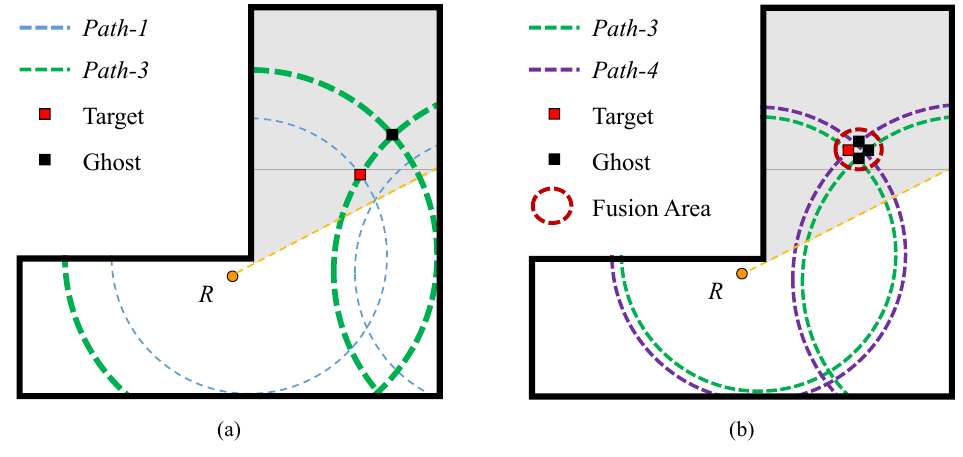
Figure 4. Different cases of ghosting in L-shaped corner scenario. ( a ) Case 1. ( b ) Case 2.